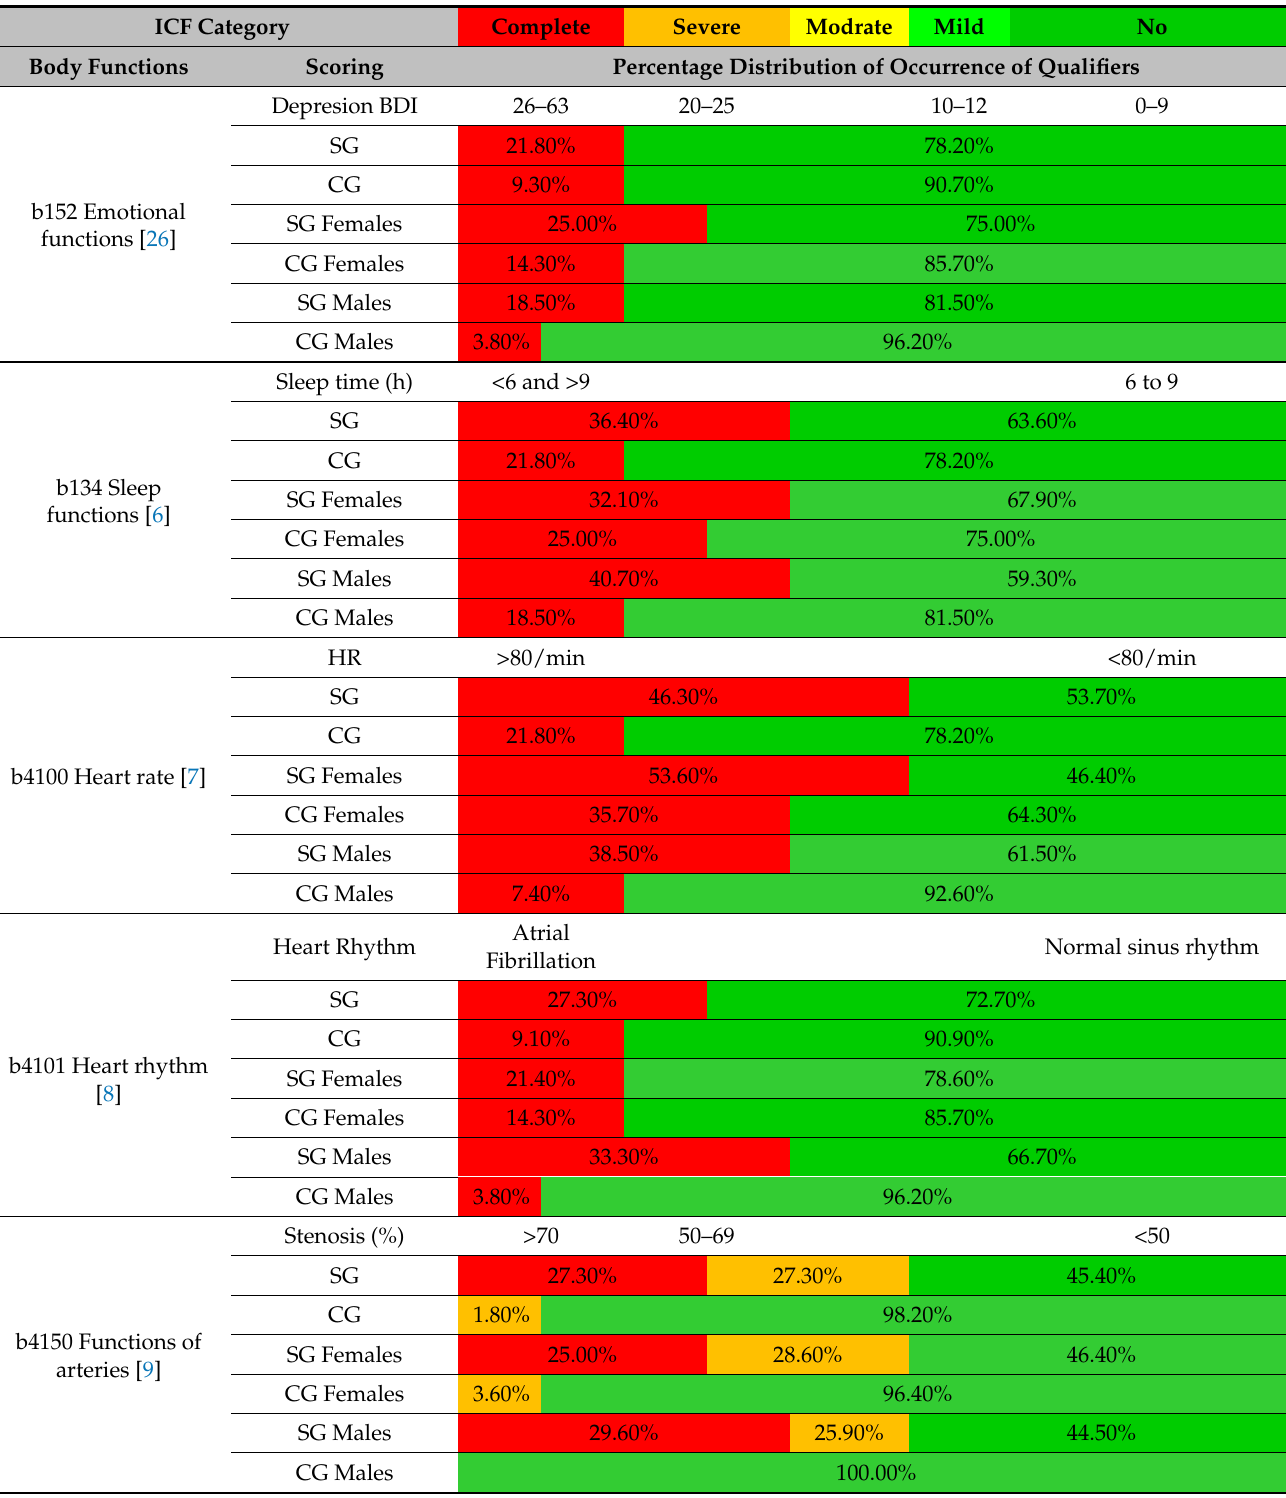
Table 3. Profile of CVD risk factors as per categories of the ICF